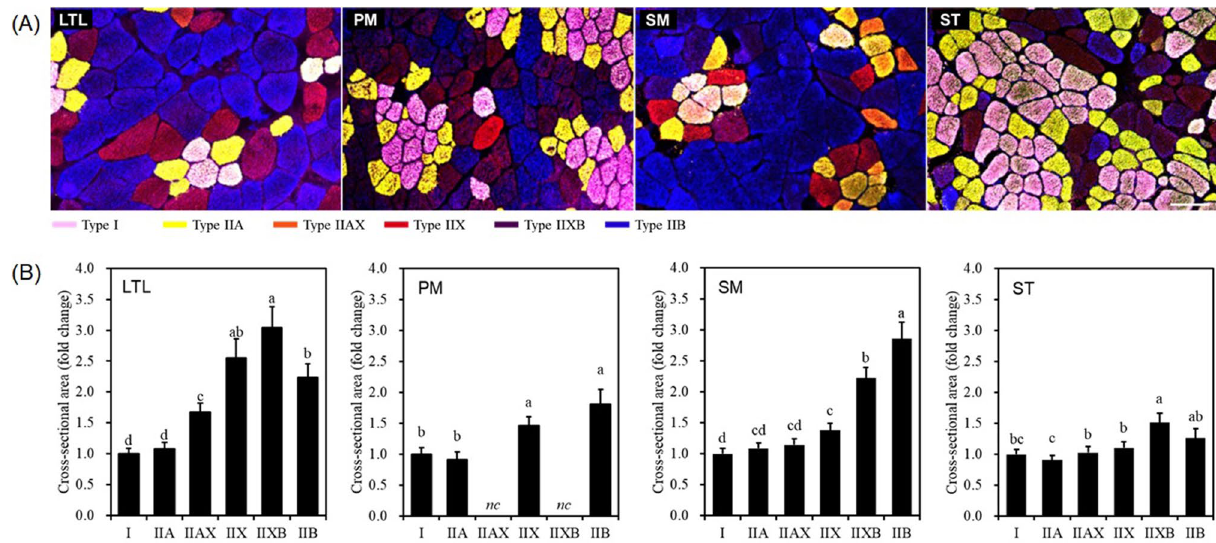
Figure 1. Representative stained cross-sections ( A ) and relative cross-sectional area ( B ) of pork skeletal muscles. LTL, M. longissimus thoracis et lumborum ; PM, M. psoas major ; SM, M. semimembranosus ; ST, M. semitendinosus ; nc , not considered. The merged images were obtained by incubation with BA-F8 (anti-myosin heavy chain (MHC) slow), SC-71 (anti-MHC 2a and 2x), BF-35 (anti-MHC slow and 2a), and BF-F3 (anti-MHC 2b). Bar = 100 µm. Different letters (a–d) on the bar in ( B ) indicate significant differences between muscle fiber types within the same muscle at P <